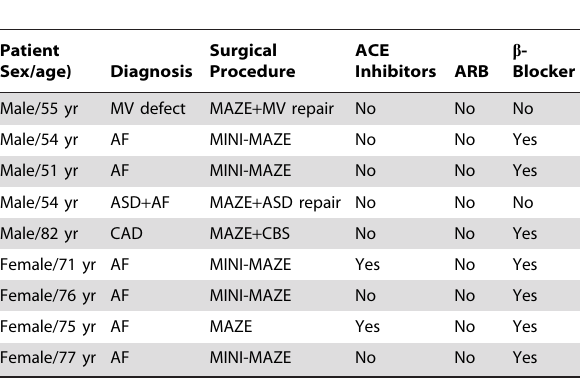
Table 2. Diagnosis, drug treatment and clinical statement of human heart